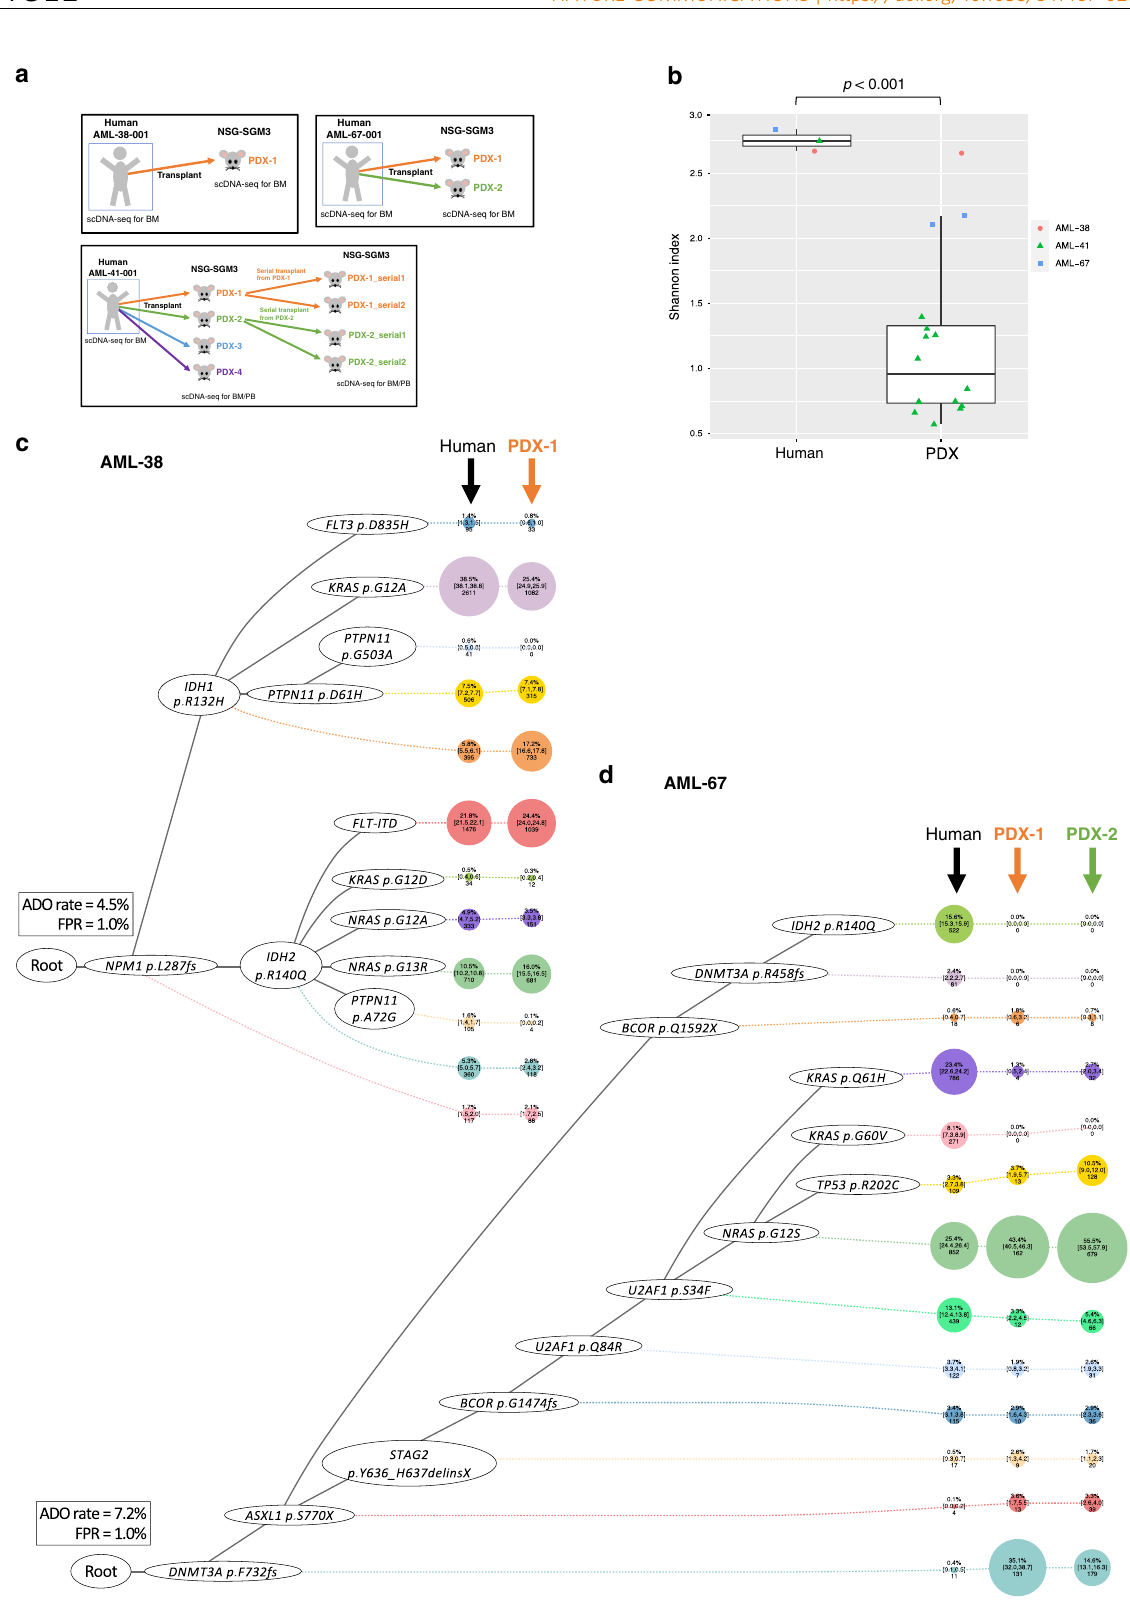
cells/mL. Next, 35 – 100 μ L of cell suspension was loaded onto a micro fl uidics cartridge and cells were encapsulated on the Tapestri instrument followed by the cell lysis and protease digestion on a thermal cycler within the individual droplet. The cell lysate was then barcoded such that each cell had a unique label 11 . The barcoded samples were then thermocycled using either 50 primer pairs speci fi c to